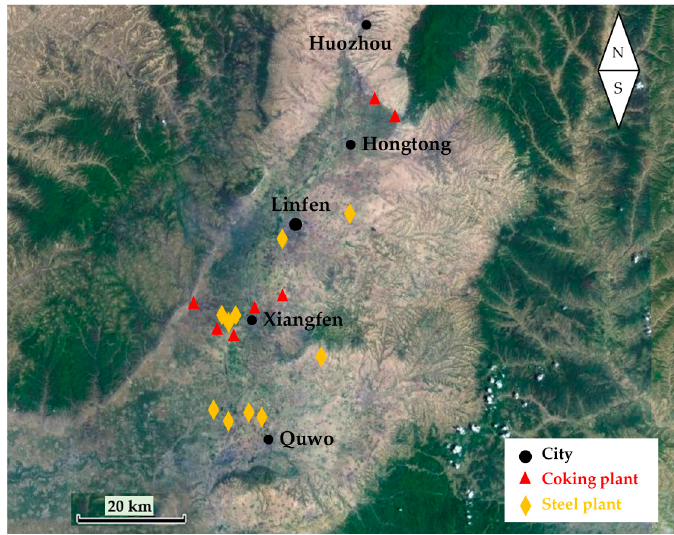
Figure 1. Topographic map of Linfen City.